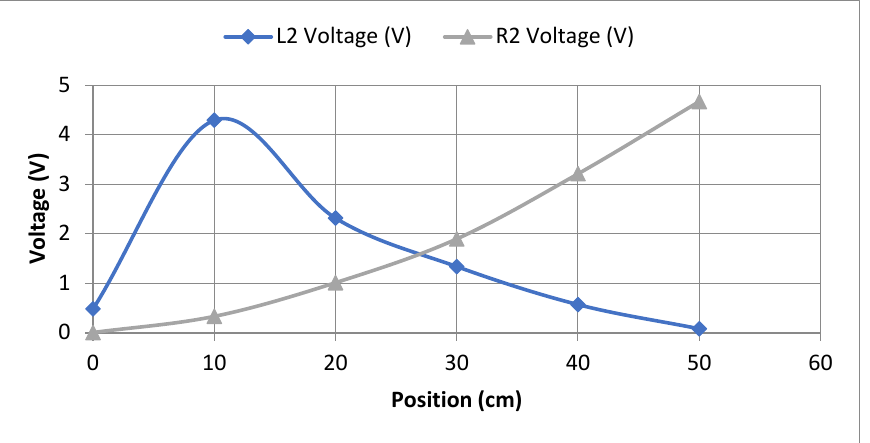
Figure 10. L2 and R2 sensors’ voltage reading for a 1 m/s load speed.